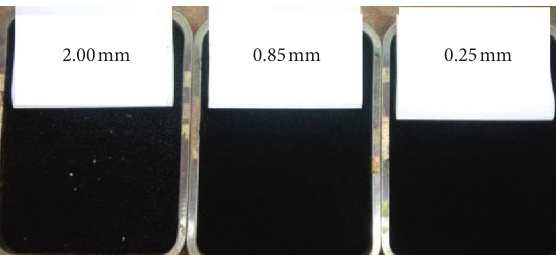
Figure 2: Different particle size rubber particles. Table 2: Results of rubber-red clay compaction experiment.